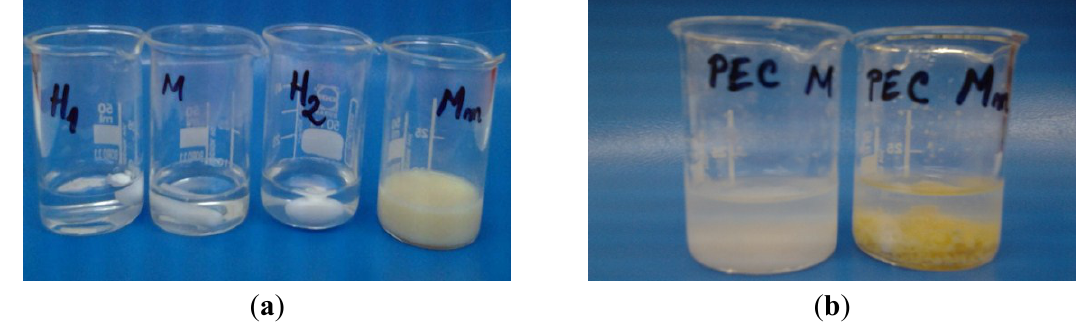
Figure 2. Images of the chitosan (CS) -M, sulfadiazine modified chitosan (SCS) -Mm and sodium hyaluronate (HA) -H 1 , H 2 solutions before mixing ( a ) and after polyelectrolyte complexes (PECs) formation ( b ). Table 1. Reaction yields obtained at pH 4.12. PECs samples